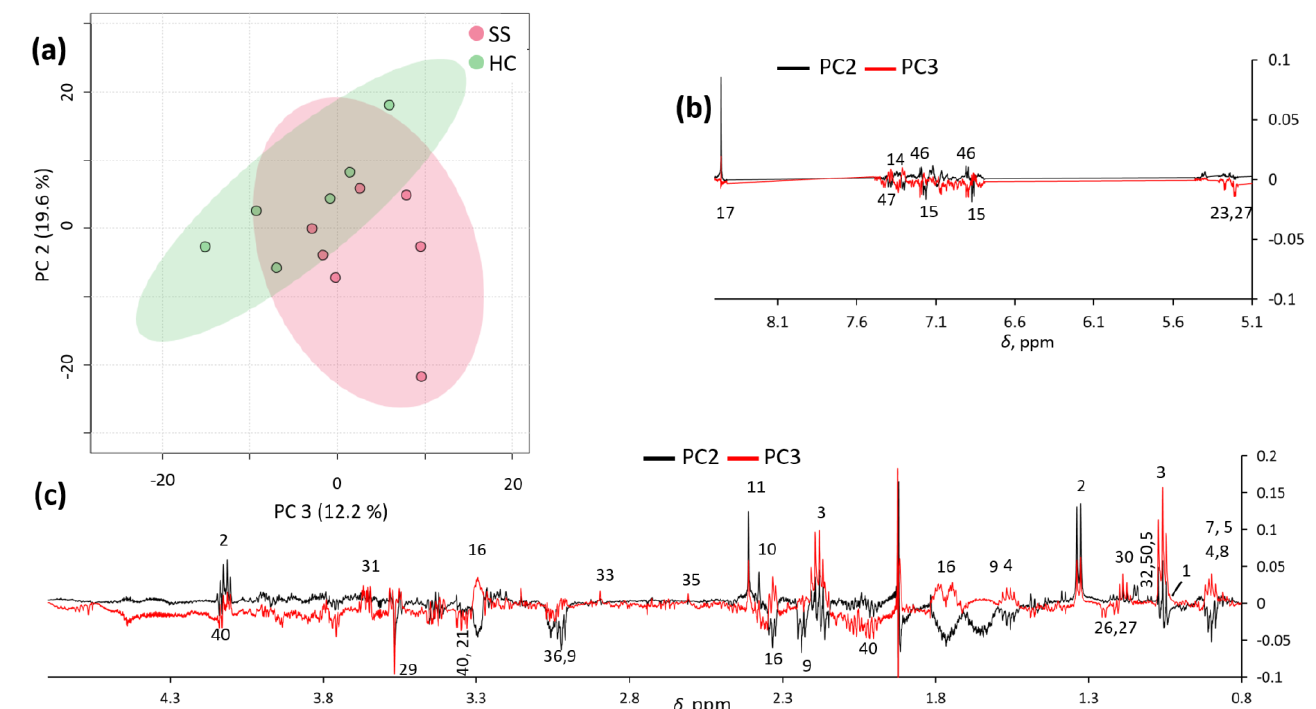
Figure 2. PC2/PC3 score plot ( a ) and loading profiles ( b , c ) obtained by PCA on spectra. PLS-DA analysis improved the separation between SS and HCs in the first two latent variables, LV1 and LV2 (Figure 3a). The LV1 loading profile (Figure 3b,c) confirmed a pool of metabolites distinctly describing each group, most of which were the same as those obtained by PCA (Table 2).